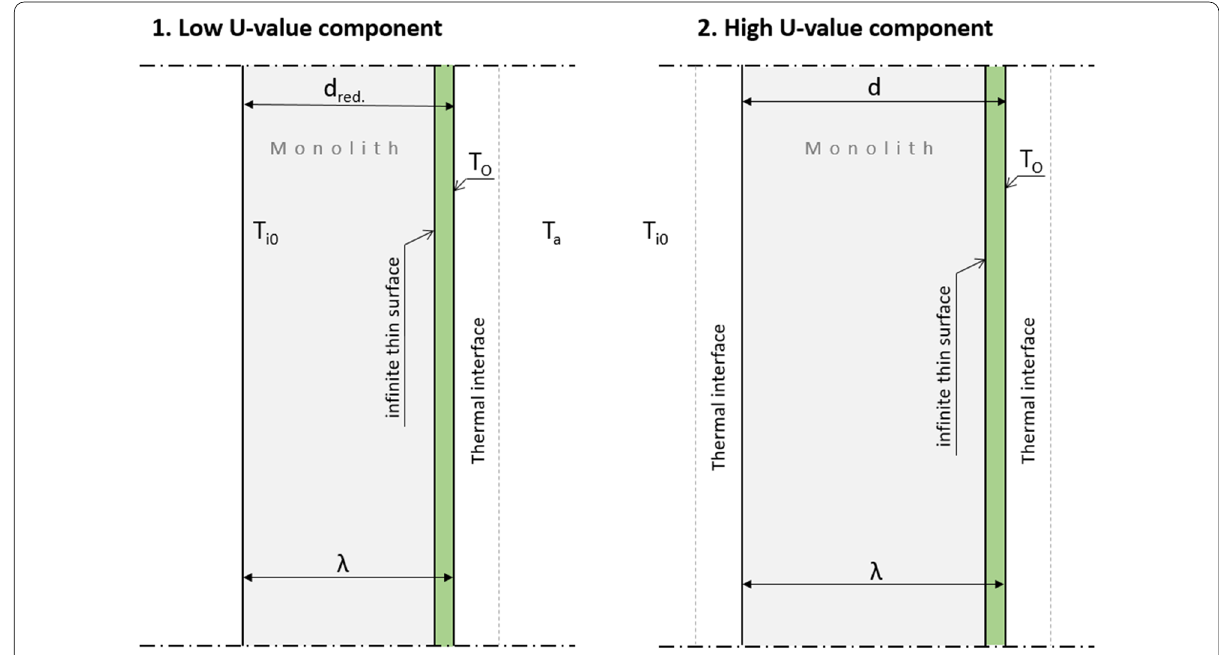
Fig. 5 Representation of the two different monolith models: 1: low heat transfer coefficient—heat storage through external components of reduced thickness; and 2: high heat transfer coefficient—heat storage by both external and internal